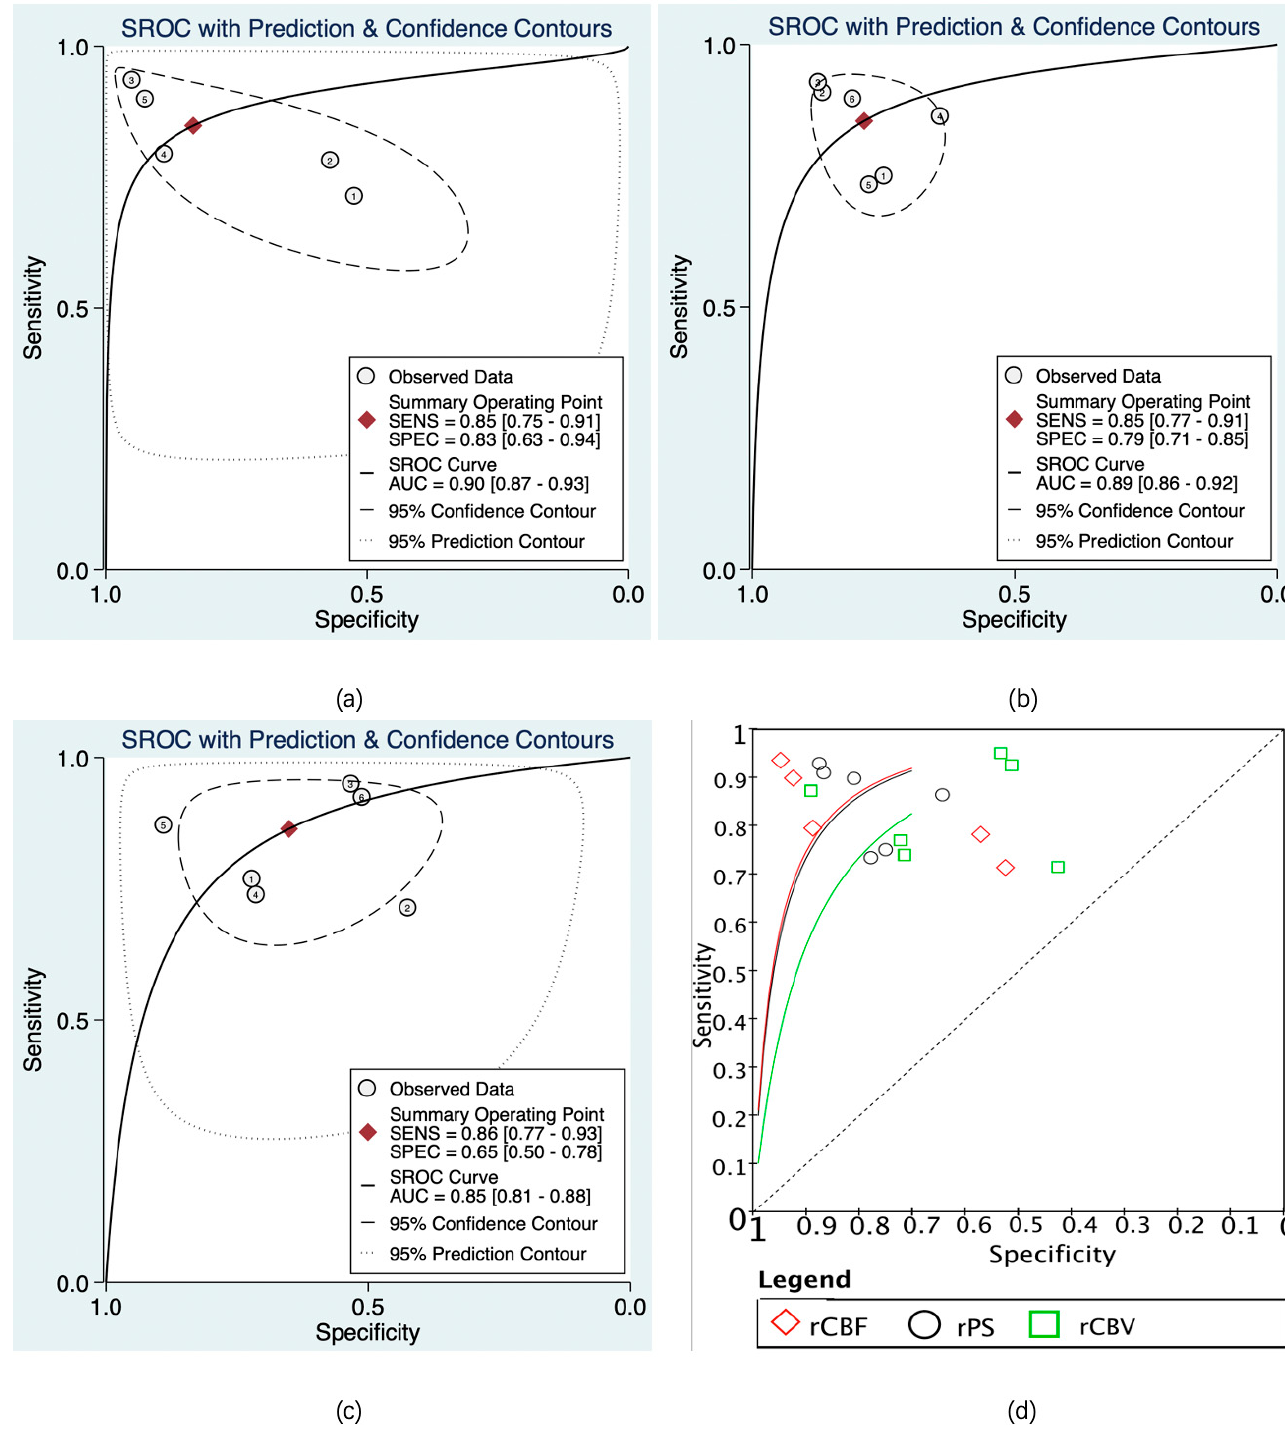
Figure 8. Summary receiver operating characteristic (SROC) of CTP parameters for diagnosis of HT. rCBF ( a ), rPS ( b ), rCBV ( c ), and SROC of rCBF, rPS, and rCBV ( d ). The numbers in the circles denote the data from different studies.